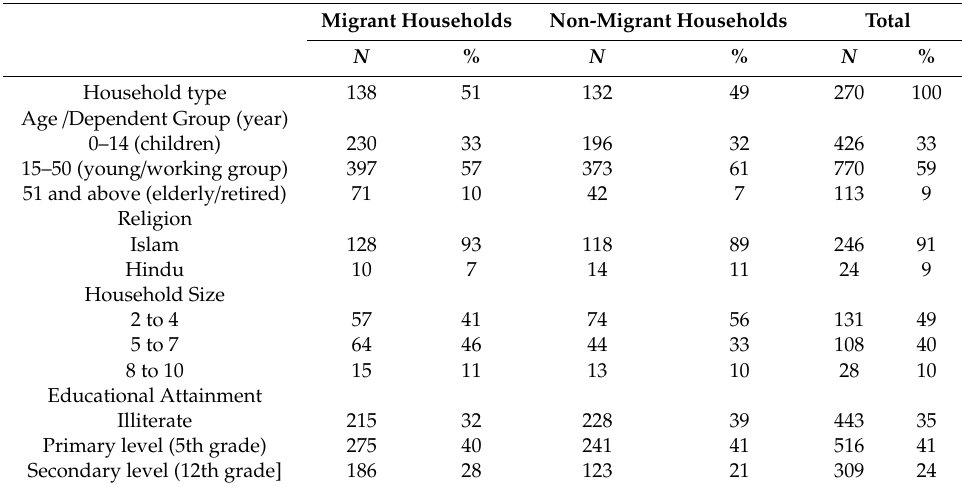
Table 2. Demographic profile of the respondent households. Migrant